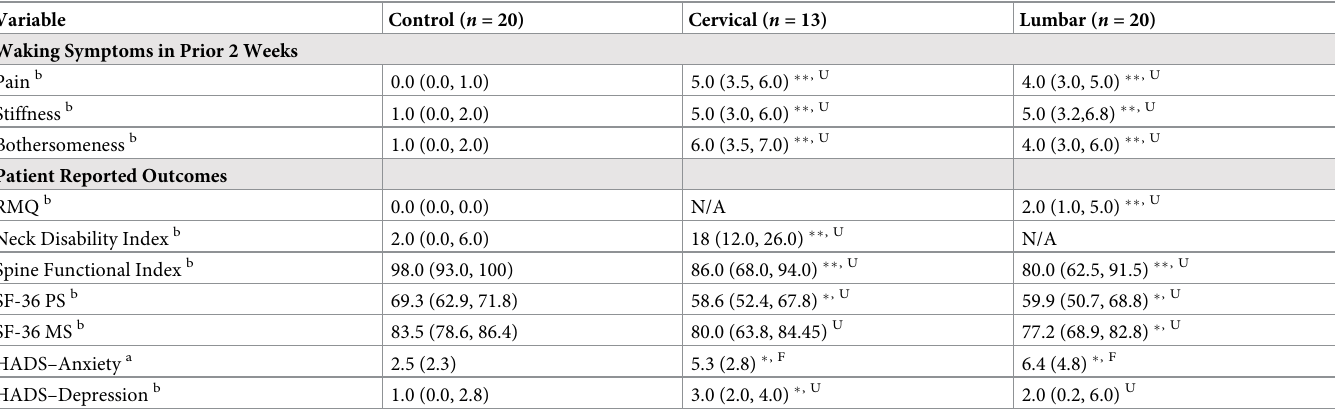
Table 2. Comparisons between Control and symptomatic groups for waking symptoms in the prior 2 weeks and patient reported